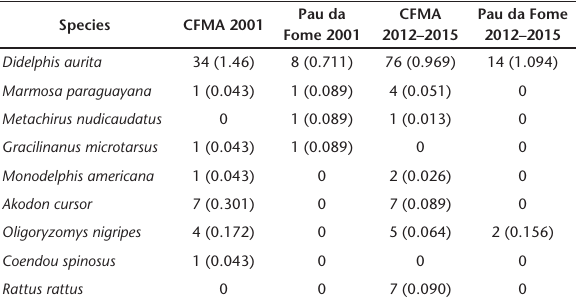
Table 2. Number of individuals captured in 2001 and 2012–2015 in CFMA and Pau da Fome, Rio de Janeiro, Brazil. Numbers in pa- renthesis are the abundances in relation to the trapping effort of each area multiplied by 100.